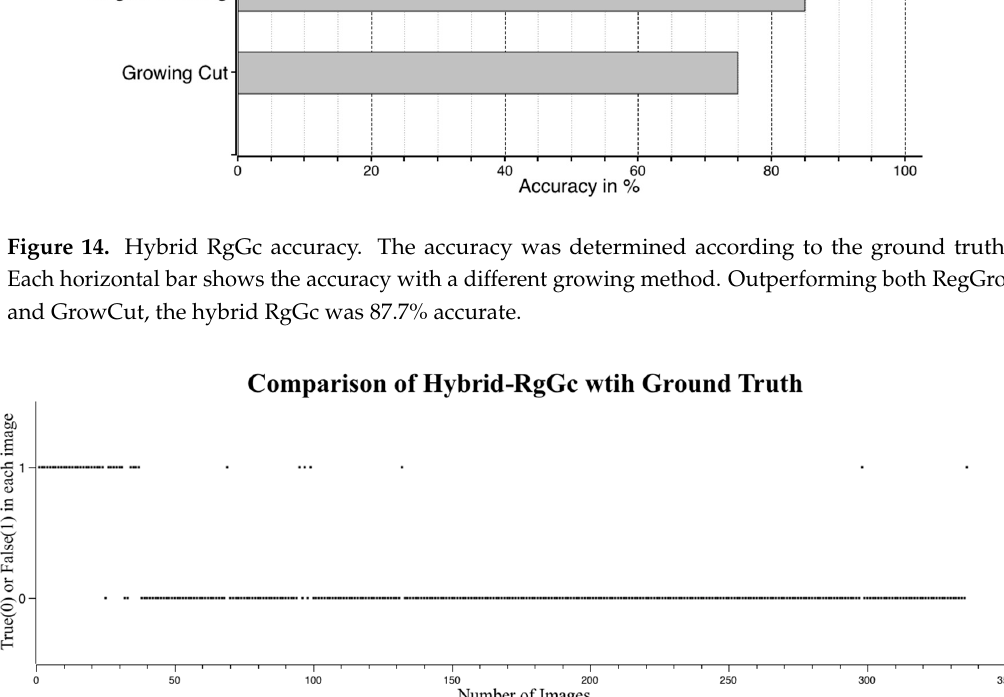
Figure 15. Segmentation success or failure with the hybrid RgGc. True (0) indicates success and False (1) indicates failure. Most false detections occurred in the first 40 images with heavy rain and fog. Both methods failed to segment the flood regions as well as the hybrid RgGc.